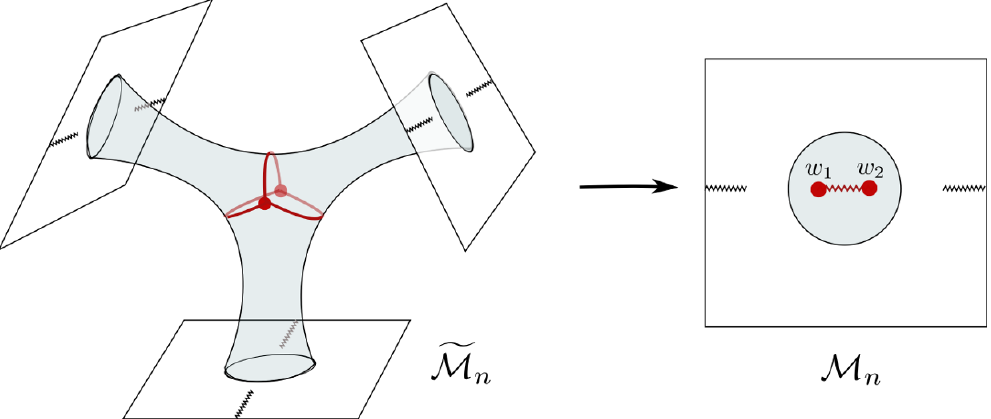
Figure 9 . Here we display the replica manifold, f M 3 , and also the manifold M 3 = f M 3 =Z 3 which has the topology of the disk with conical singularities at two points w 1 and w 2 which corresponds to the (cid:12)xed points of the Z 3 action on f M 3 . We parametrize this disk in terms of the holomorphic coordinate w . The exterior regions of f M n are also glued together cyclically along the